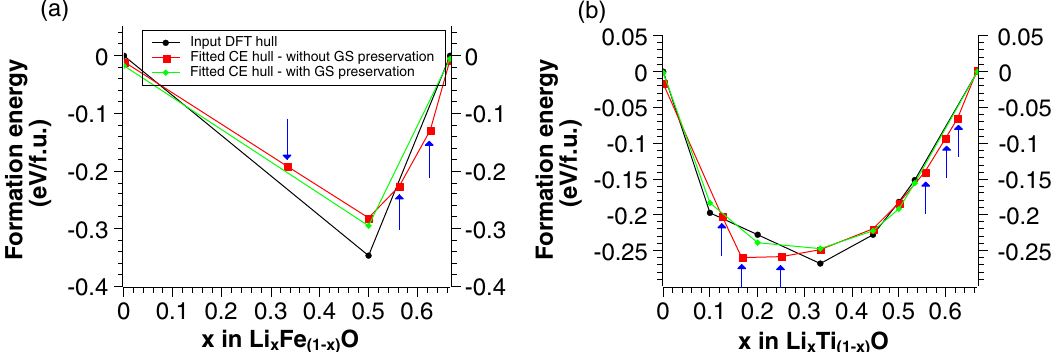
Fig. 2 Input hull as obtained from density functional theory ( black lines and circles ), cluster expansion hull fi tted using the conventional (unconstrained) compressive sensing method ( red lines and squares ), and ground-state preserving cluster expansion hull fi tted with the quadratic programming method of the present work ( green lines and diamonds ) for ( a ) Li x Fe (1 − x ) O and ( b ) Li x Ti (1 − x ) O. The input ground-state con fi gurations for ( a ) Li x Fe (1 − x ) O correspond to FeO, LiFeO 2 and Li 2 FeO 3 and for ( b ) Li x Ti (1 − x ) O correspond to TiO, Li 1 Ti 9 O 10 , Li 2 Ti 8 O 10 , Li 3 Ti 6 O 9 , Li 4 Ti 5 O 9 , Li 2 TiO 3 , LiTiO 2 , Li 8 Ti 7 O 15 and Li 2 TiO 3 . Arrows are used to mark the over-stabilized unstable con fi gurations. The sparseness parameter, μ , was chosen to be 0.144 for both